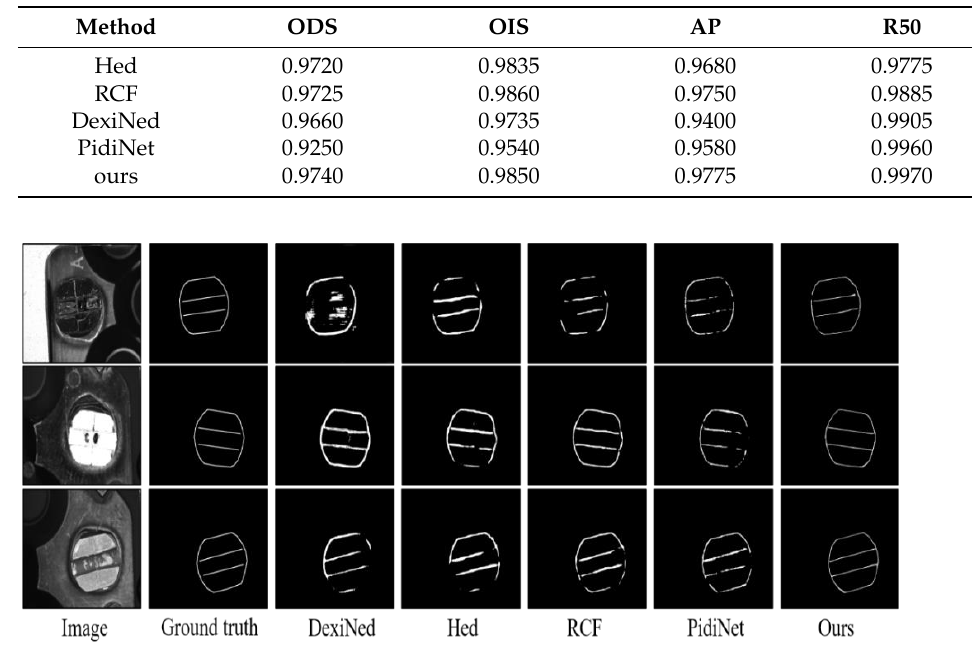
Figure 10. Results of different methods.